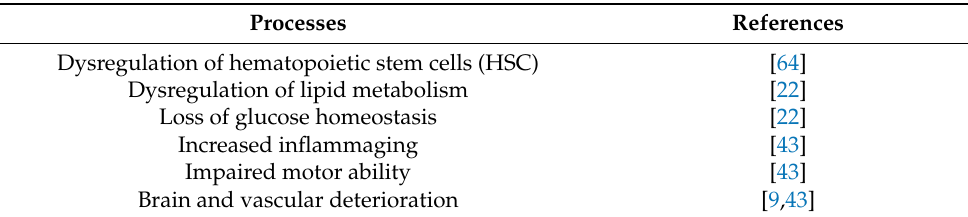
Table 3. AhR dysregulation in